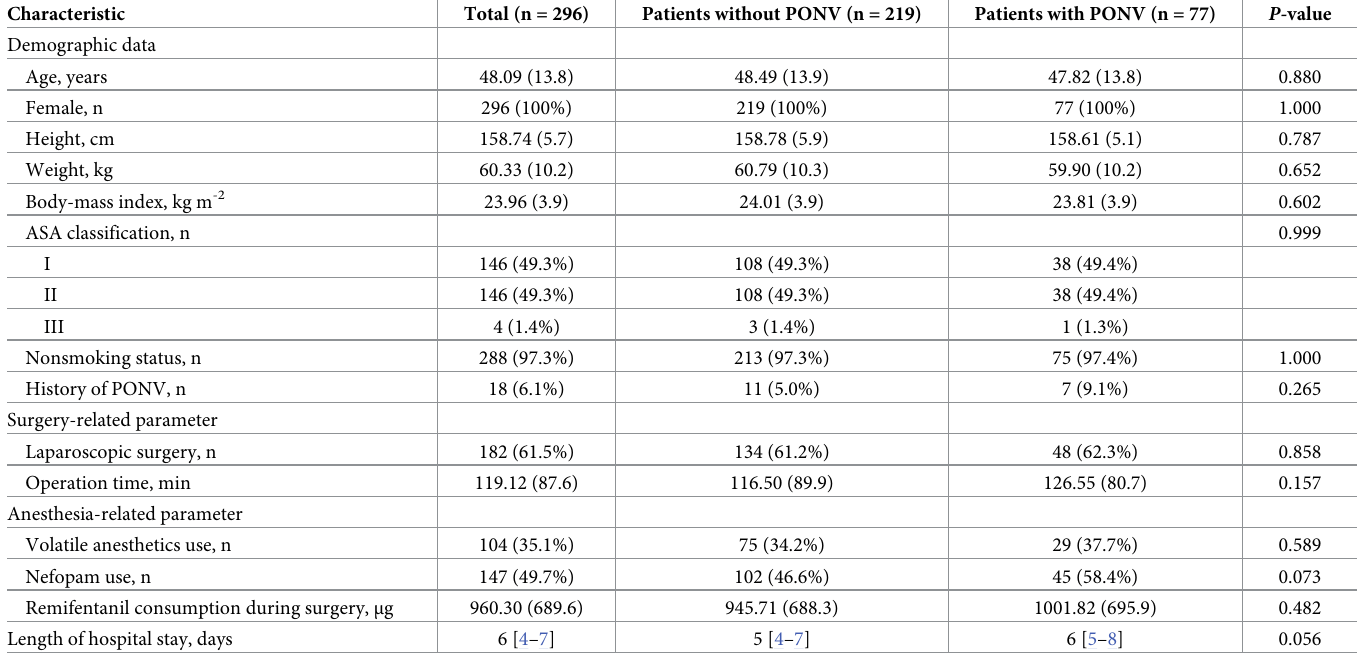
Table 4. Baseline patient characteristics by postoperative nausea and